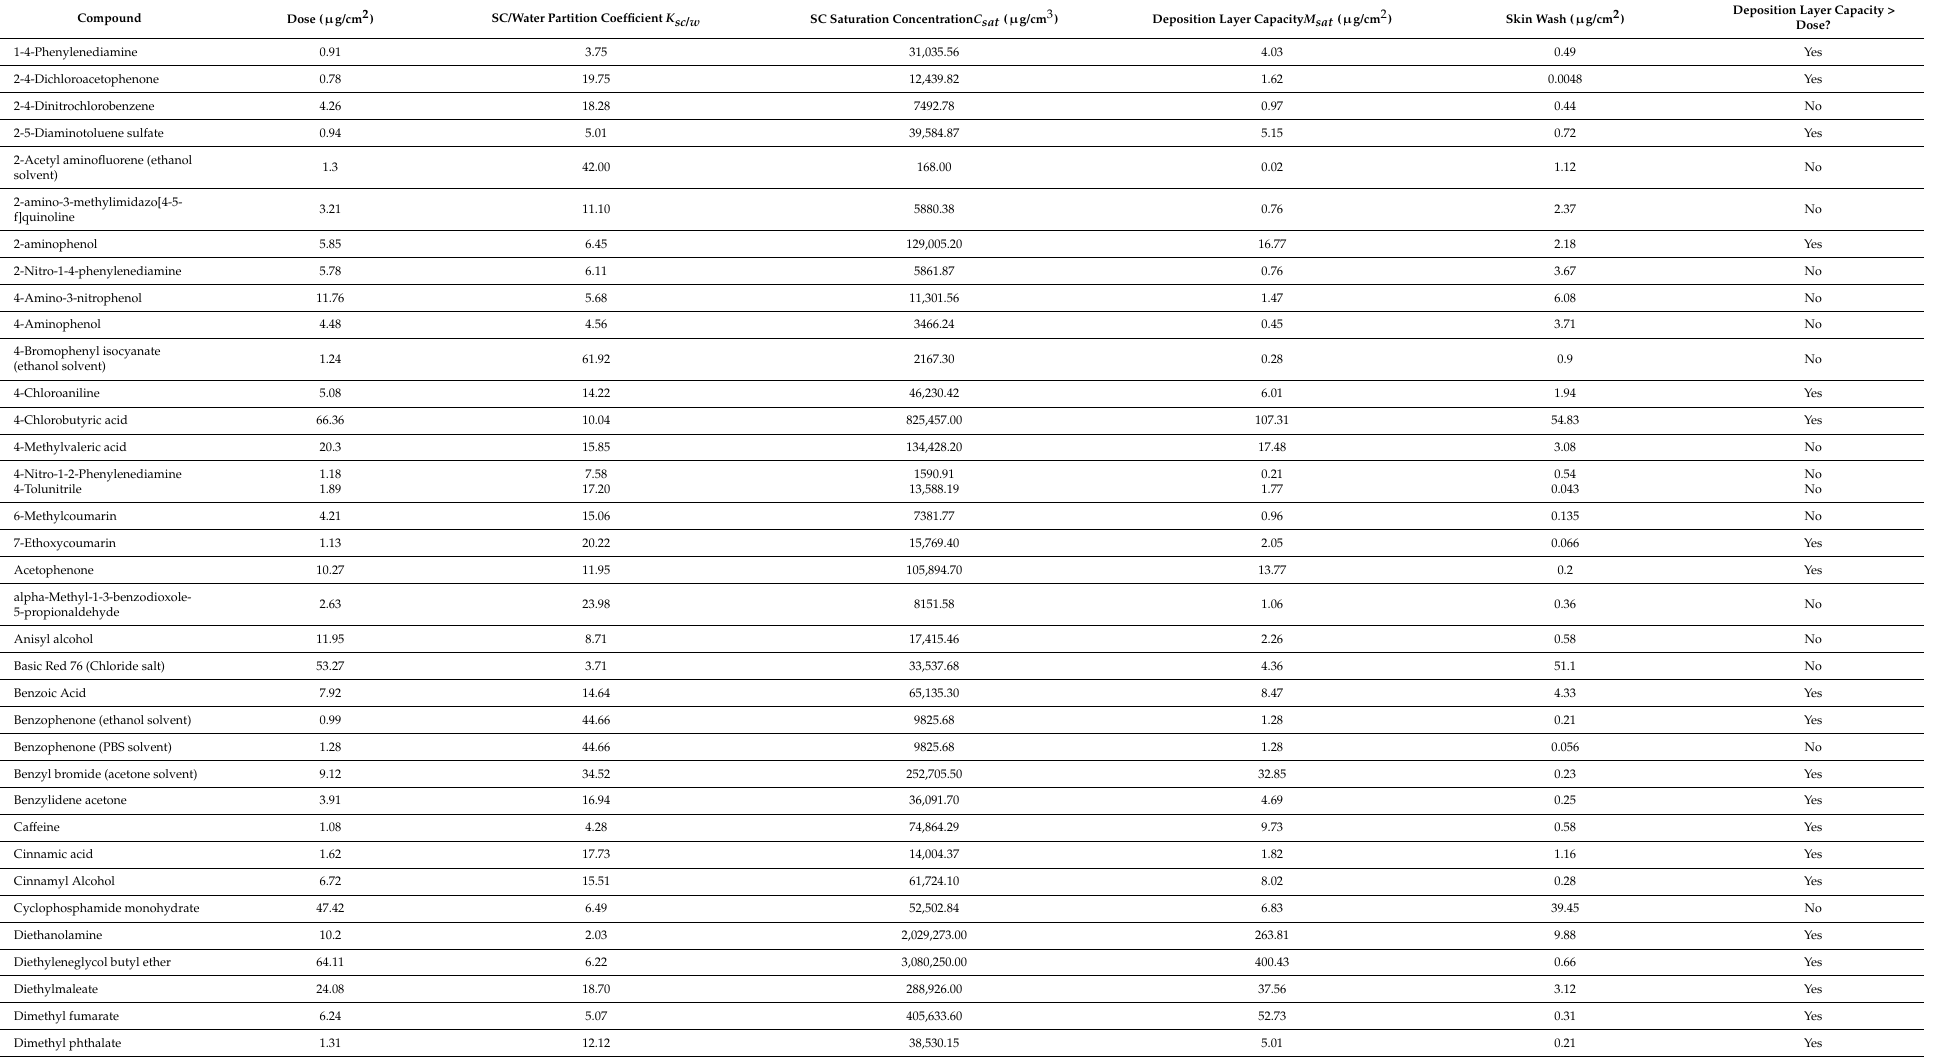
Table A5. Dose and Model A deposition layer capacities for all compounds tested in Hewitt et al.